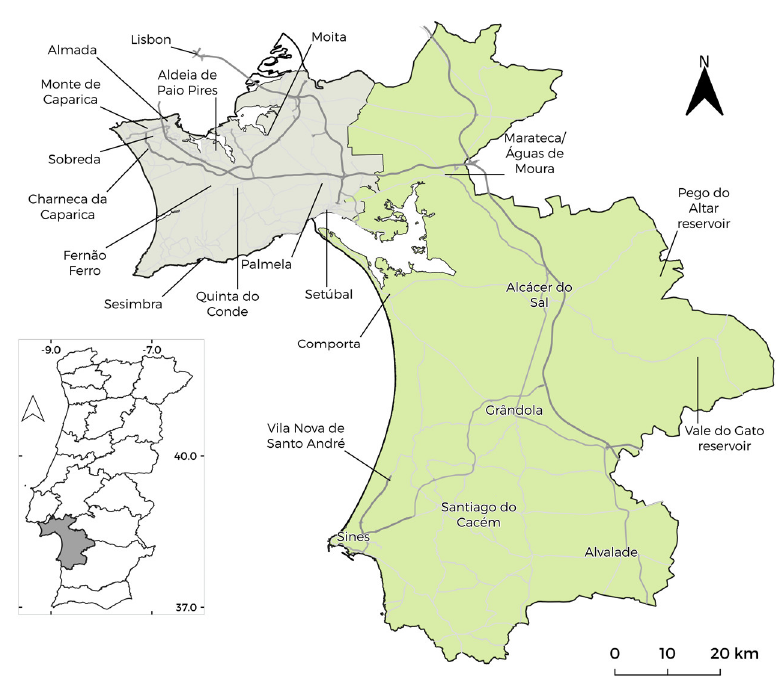
Figure 1. Geographical setting of the study area, the district of Setúbal, its municipalities and relevant areas. The grey area is referred to as the north-western region, whereas the green area is referred to as the eastern region. Major roads are grey lines with their relative importance displayed by different thicknesses.